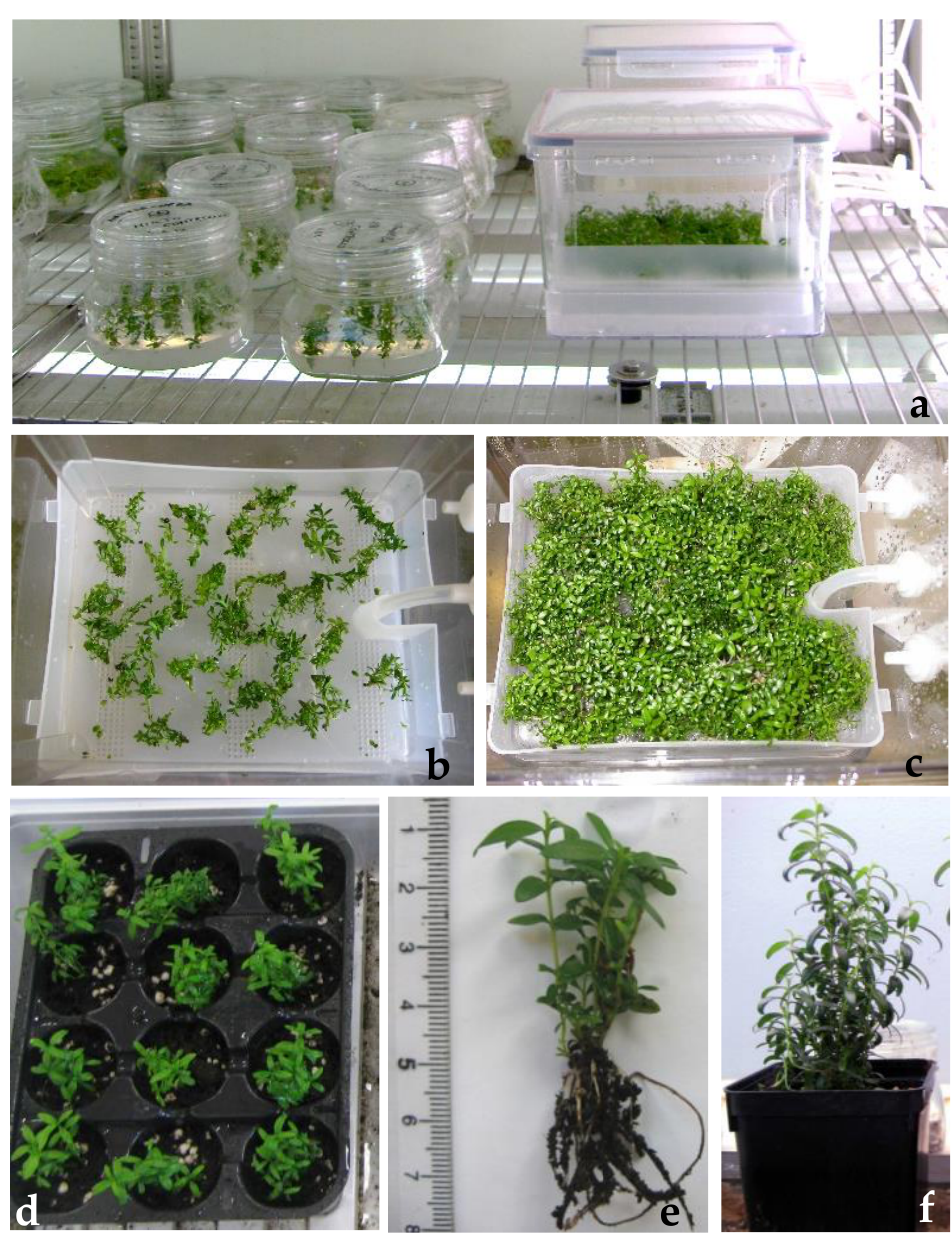
Figure 4. Micropropagation of Myrtus communis in semi-solid medium and in PlantForm bioreactor ( a ); shoots at the beginning of culture in PlantForm ( b ); shoots after 8 weeks of culture in PlantForm ( c ); plants after 2 weeks ( d ), 4 weeks ( e ), and 4 months ( f ) of ex vitro acclimatization (Photo by De Carlo A).